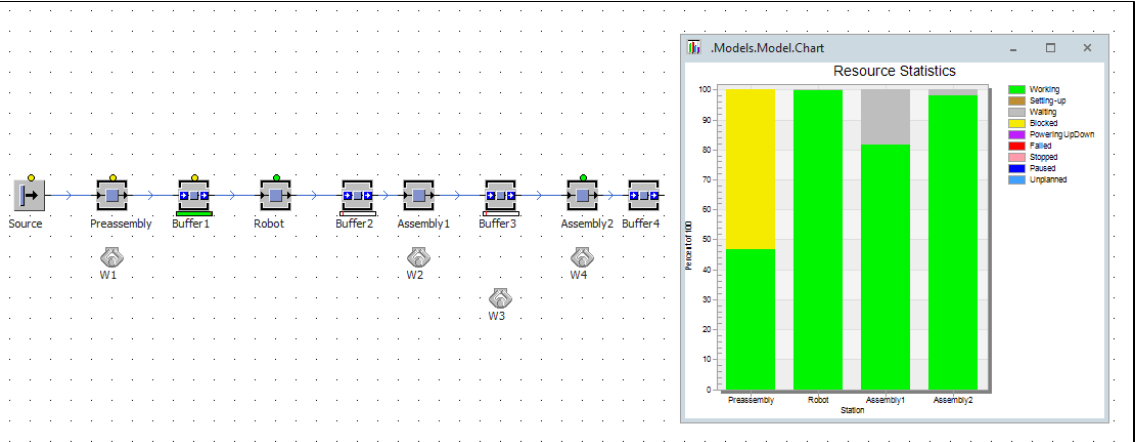
Figure 5. Variant 1b (one robot, four people).